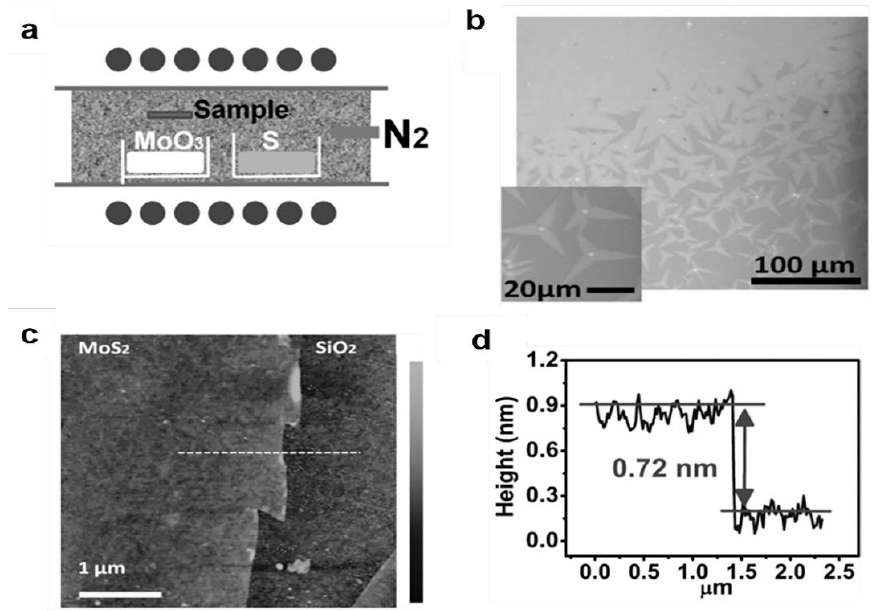
Figure 12. ( a ) Schematic illustration for the experimental set-up; ( b ) HRTEM image of MoS 2 monolayer; ( c ) enlarged HR-TEM image of the marked area in figure ( c ) with an inset showing the SAED pattern; ( d ) in-plane XRD result for the MoS 2 monolayer [128]. Copyright © 2021 WILEY-VCH Verlag GmbH & Co. KGaA, Weinheim.